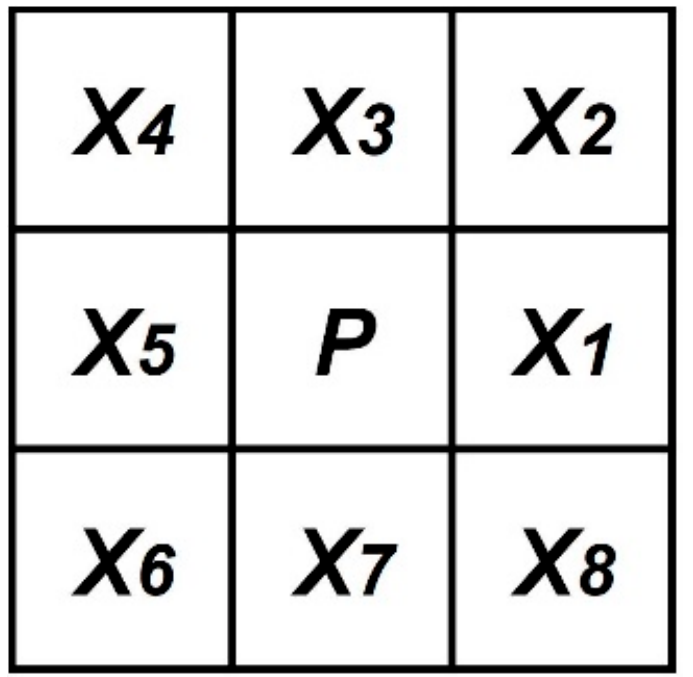
Figure 4. Pixels of the neighborhood of